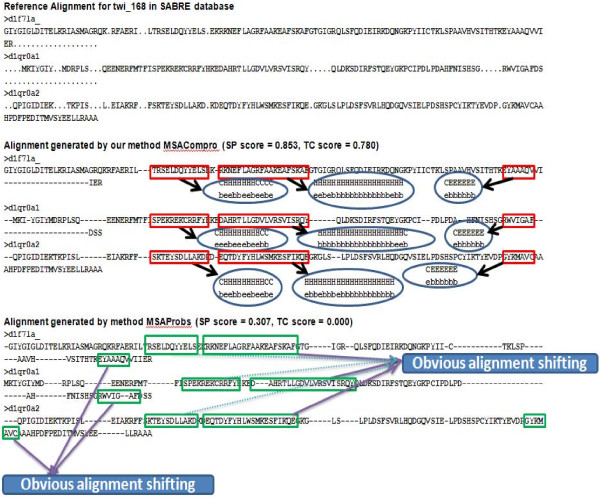
an example in SABRE database comparing the alignments generated by our method and MSAProbs. The reference alignment and resulting alignments generated by both methods are respectively shown in the figure. The correct alignment regions significantly improved by our MSACompro after taking structural information are marked in red rectangles. In contrast, the corresponding incorrect alignment regions generated by MSAProbs are represented in green rectangles. The predicted secondary structure and solvent accessibility information for the correctly aligned regions are shown in circles.